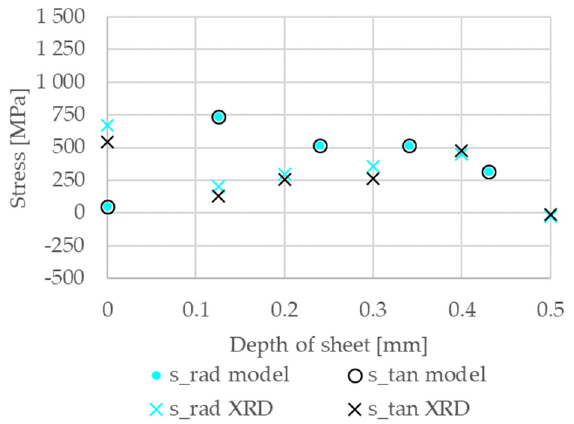
Figure 10. Simulation results for the conditions after rapid cooling compared to residual stresses in radial (s_rad XRD) and tangential direction (s_tan XRD) of XRD measurements in the sheet depth for the centre of the weld. Note that the calculated radial s_rad model and tangential s_tan model stress distribution overlap.